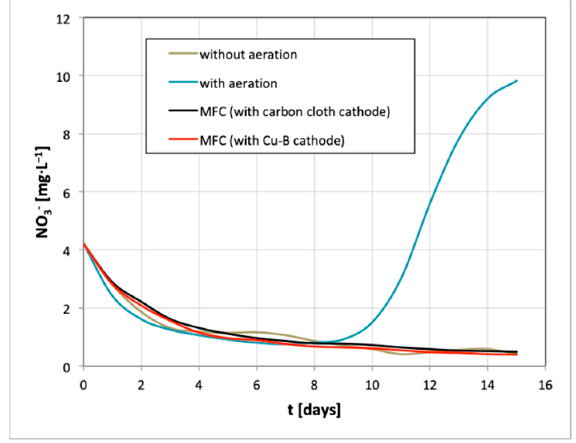
Figure 12. Trend of NO 3– reduction during wastewater treatment performed at the different reactors.